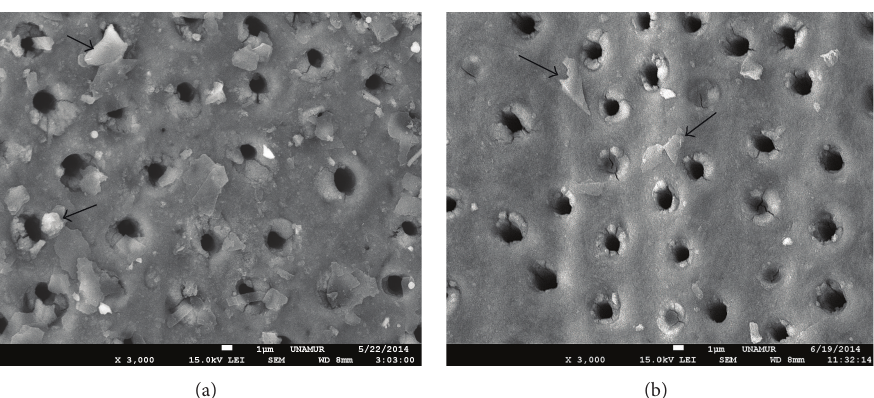
Figure 2: SEM view of Nd:YAP lased dentin treated previously with EDTA (18%). SEM view of exposed dentine with Nd:YAP laser beam at 0.9 W (a) and 1.4 W (b). We can only notice a slight tubules narrowing. Arrows show the graphite particles still existing on the dentinal surface (not disintegrated by the laser beam). Magnification: 3000x.